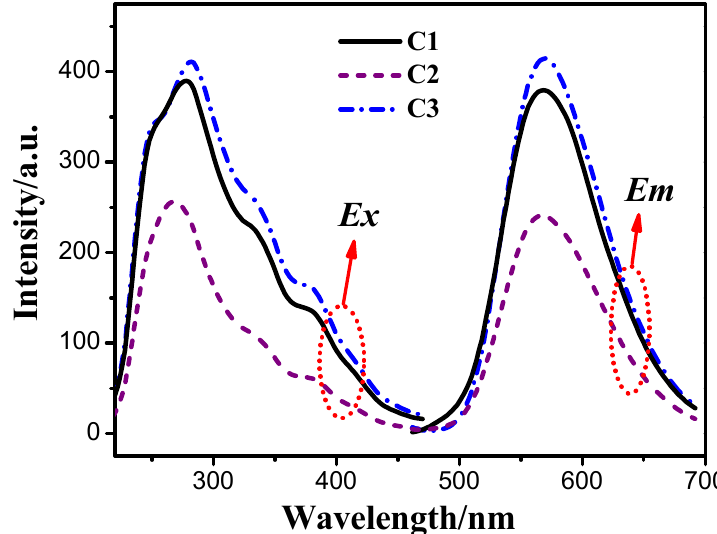
Figure 3. Excitation ( E x , λ em = 580 nm) and emission ( E m , λ ex = 342 nm) spectra of the cationic iridium(III) complexes in CH 2 Cl 2 at 1.0 × 10 − 5 mol·L − 1 at room temperature.